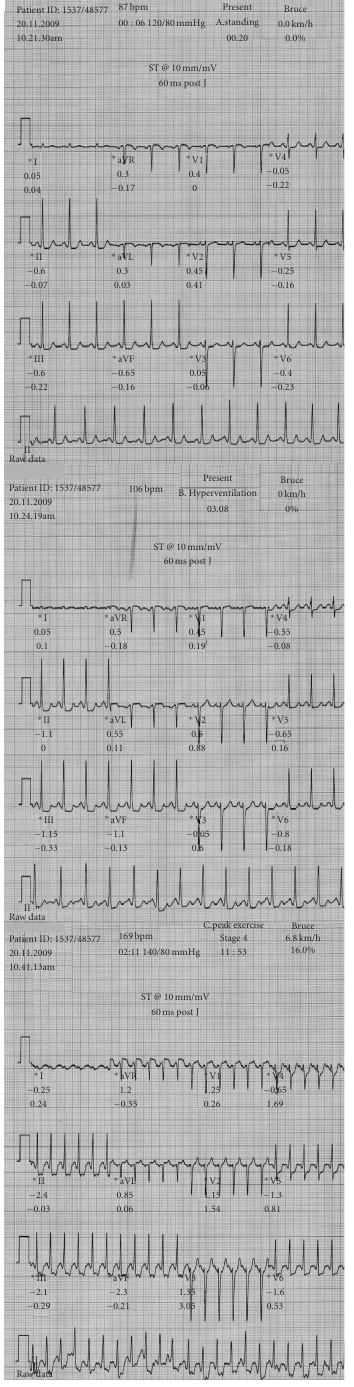
Figure 1: Electrocardiographic (ECG) recordings from a 48-year old woman with mitral valve prolapse undergoing maximal tread- mill test. A. Resting status-standing position-normal breathing: normal ECG, B. Resting status-standing position-hyperventilation: ST-segment depression in leads II, III, aVF ( ≈ 0.13 mV)/V 4 , V 5 , V 6 ( ≈ 0.1mV), C. Peak exercise-standing position: ST-segment depression in leads II, III, aVF ( ≈ 0.23 mV)/V 4 , V 5 , V 6 ( ≈ 0.16mV). This was a false positive exercise test since this woman had a normal coronary